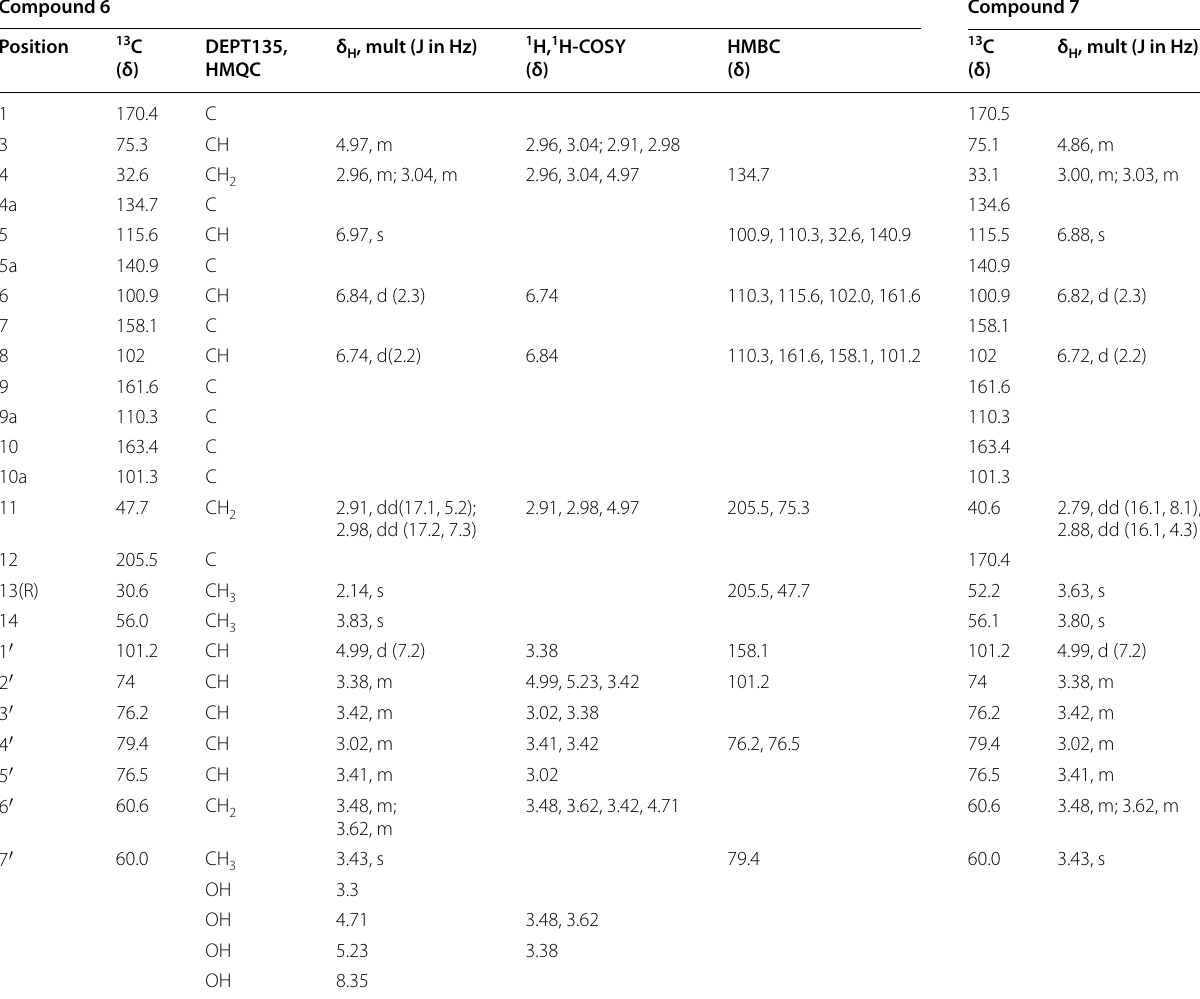
Table 3 1D and 2D NMR spectral data (δ in ppm) of compound 6 , and 1 H and 13 C NMR spectral data of compound 7 Compound